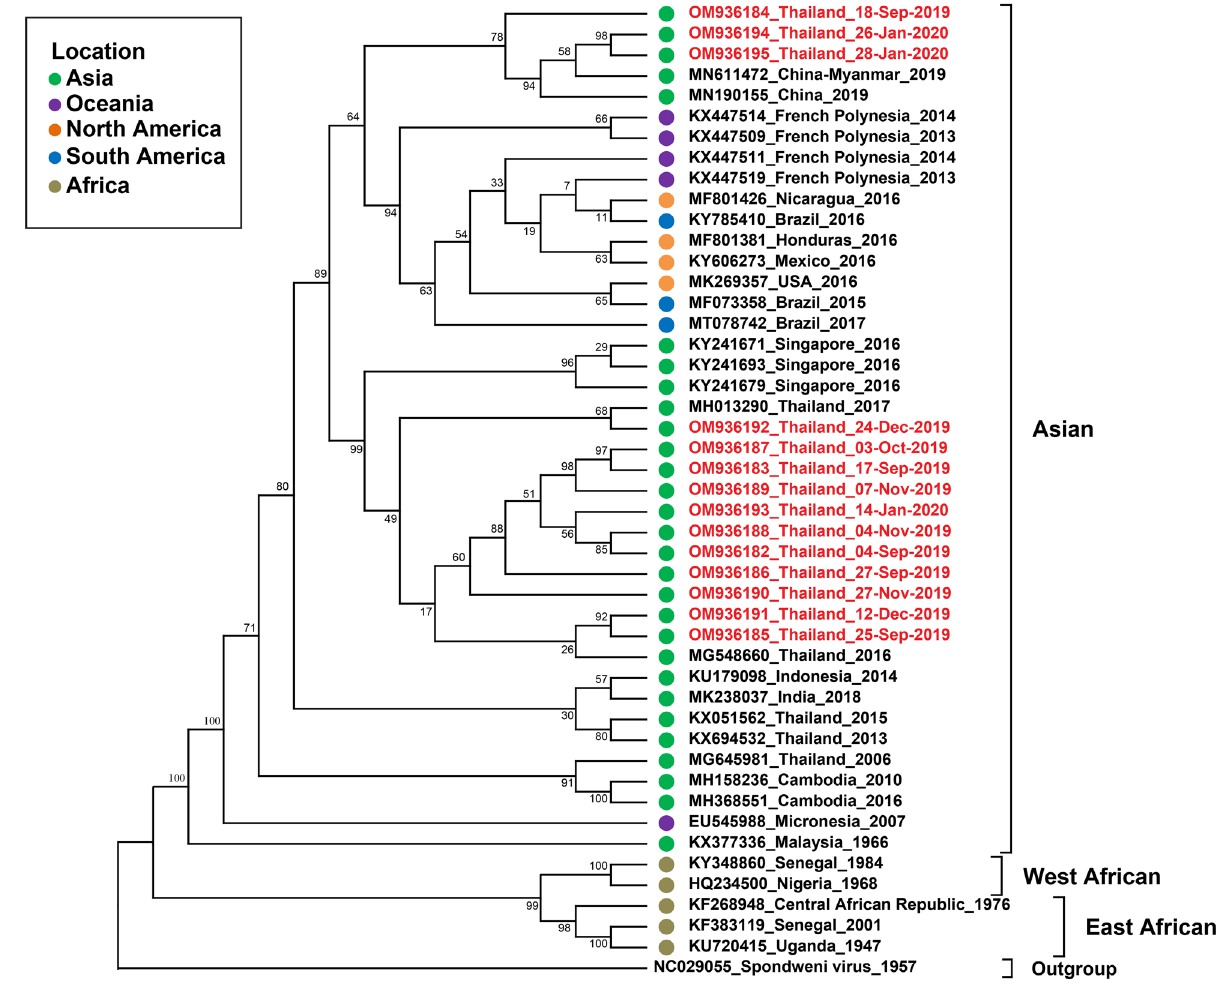
Figure 2. Phylogenetic analysis of the ZIKV structural protein gene coding region (C-prM-E). The maximum- likelihood tree of the ZIKV structural protein gene (C-prM-E) sequences was generated using the TNe + I + G4 model with 1000 ultrafast bootstrap replicates. Bootstrap values are indicated at branch nodes. ZIKV Thai strains from this study are shown in